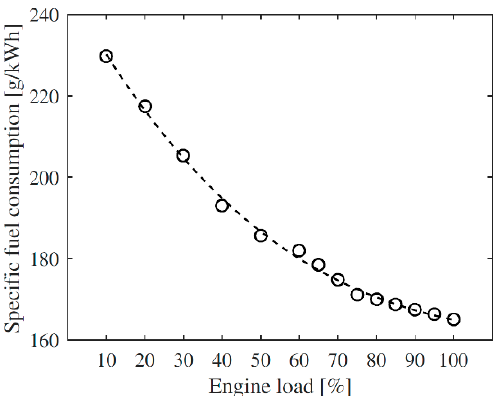
Figure 3. Engine specific fuel consumption as a function of the load. Example for the engine Wärtsilä 6L20DF. Dots: engine data; dashed line: non-linear approximation. The average and maximum relative deviations from the data were of 0.31% and 1.11%, respectively.